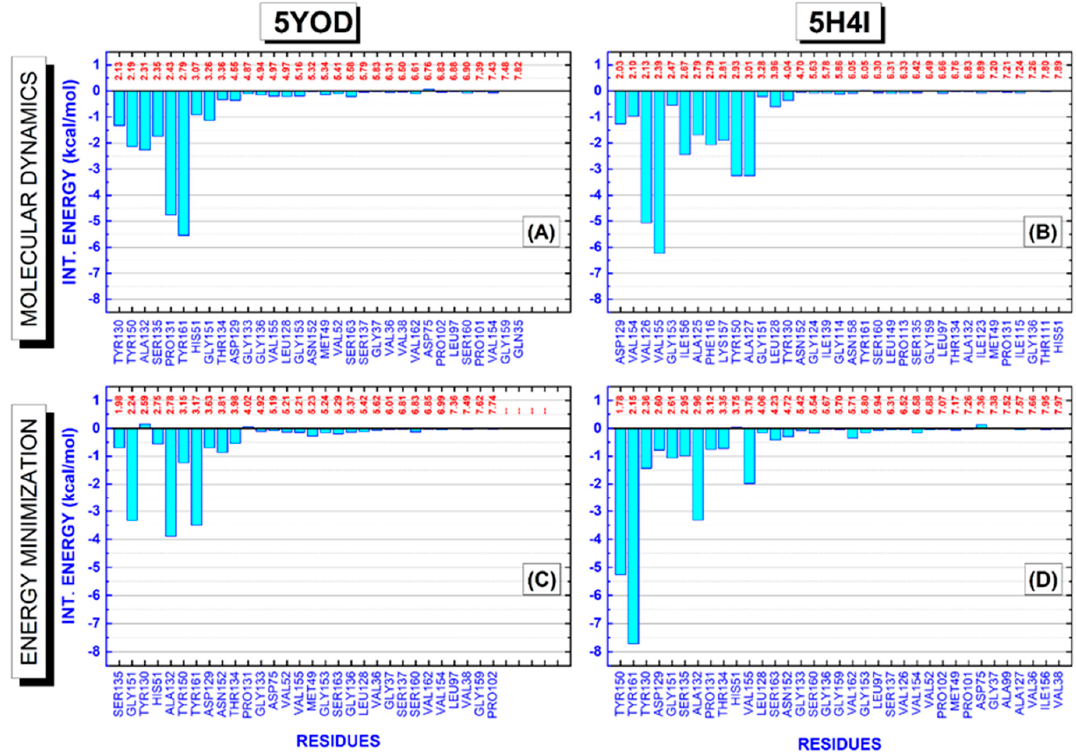
Figure 7. The binding site, interaction energy, and residue domain (BIRD) panels show the MFCC protein–ligand interaction energies with their respective distances to the ligand. ( A , C ): 5YOD (md5/dft) and 5YOD (em/dft) structures, respectively. ( B , D ): 5H4I (md5/dft) and 5H4I (em/dft) (md5/dft) and 5YOD (em/dft) structures, respectively. ( B , D ) 5H4I (md5/dft) and 5H4I (em/dft) structures, respectively. structures,